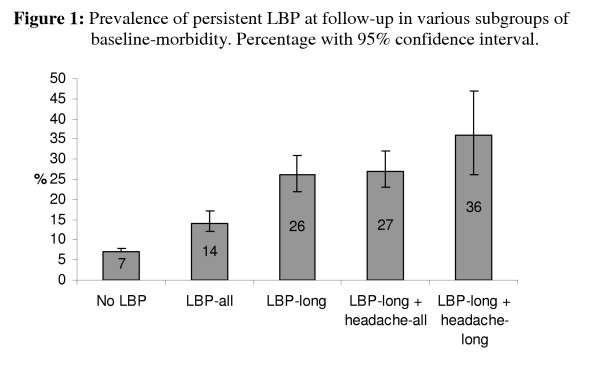
Prevalence of persistent LBP at follow-up in various subgroups of baseline-morbidity. Percentage with 95% confidence interval.